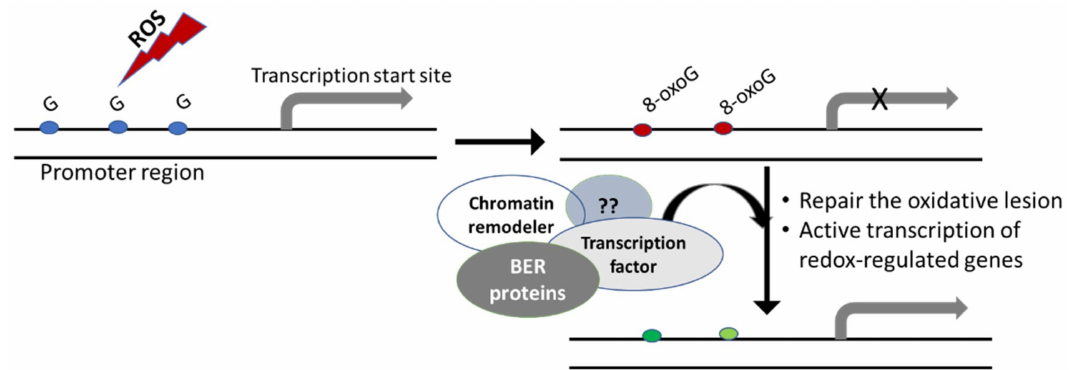
Figure 2. The influence of guanine oxidation at the promoter region on gene expression. Reactive oxygen species (ROS) induces oxidation of guanine to 8-oxoG. Gene promoters are enriched in guanine and sequence motifs prone to form G4 DNA structures. Formation of 8-oxoG is also shown to induce critical topological changes in DNA structure. Binding of 8-oxoG by BER proteins may facilitate the site-specific recruitment of specific transcription factors, chromatin remodelers and other accessory factors (shown as ??). These factors likely work in concert to repair the oxidative base lesion (shown by green) and activate transcription of redox-regulated genes for an adequate cellular